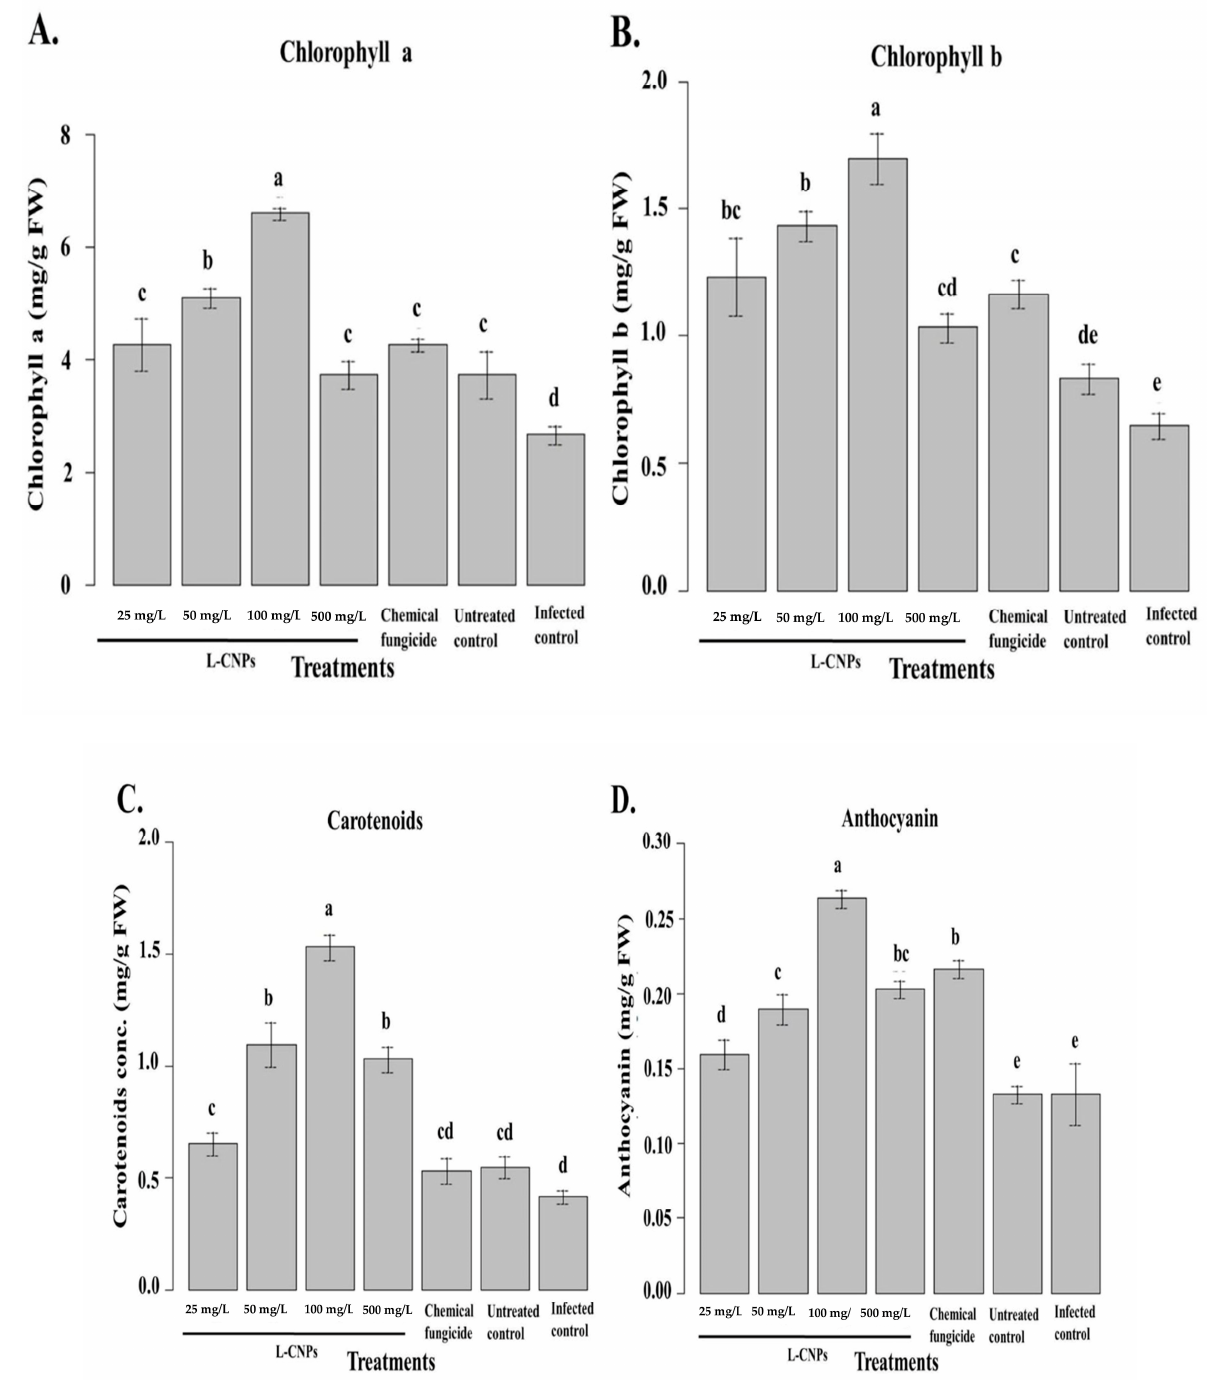
Figure 6. Effect of the treatment with L-CNPs on the photosynthetic pigments of maize samples compared to the chemical fungicide and the untreated controls. (L-CNPs25, L-CNPs50, L-CNPs100, and L-CNPs500) refer to L-CNPs concentration applied to seed for priming ( A ); effects of the treatments with L-CNPs on the chlorophyll a; ( B ) chlorophyll b; ( C ) carotenoids, and ( D ) anthocyanin compared to the untreated control. The values were recorded on seedlings at 14 DAS. Letters in the figure, if different, indicate statistically significant differences of p < 0.05 between treatments .